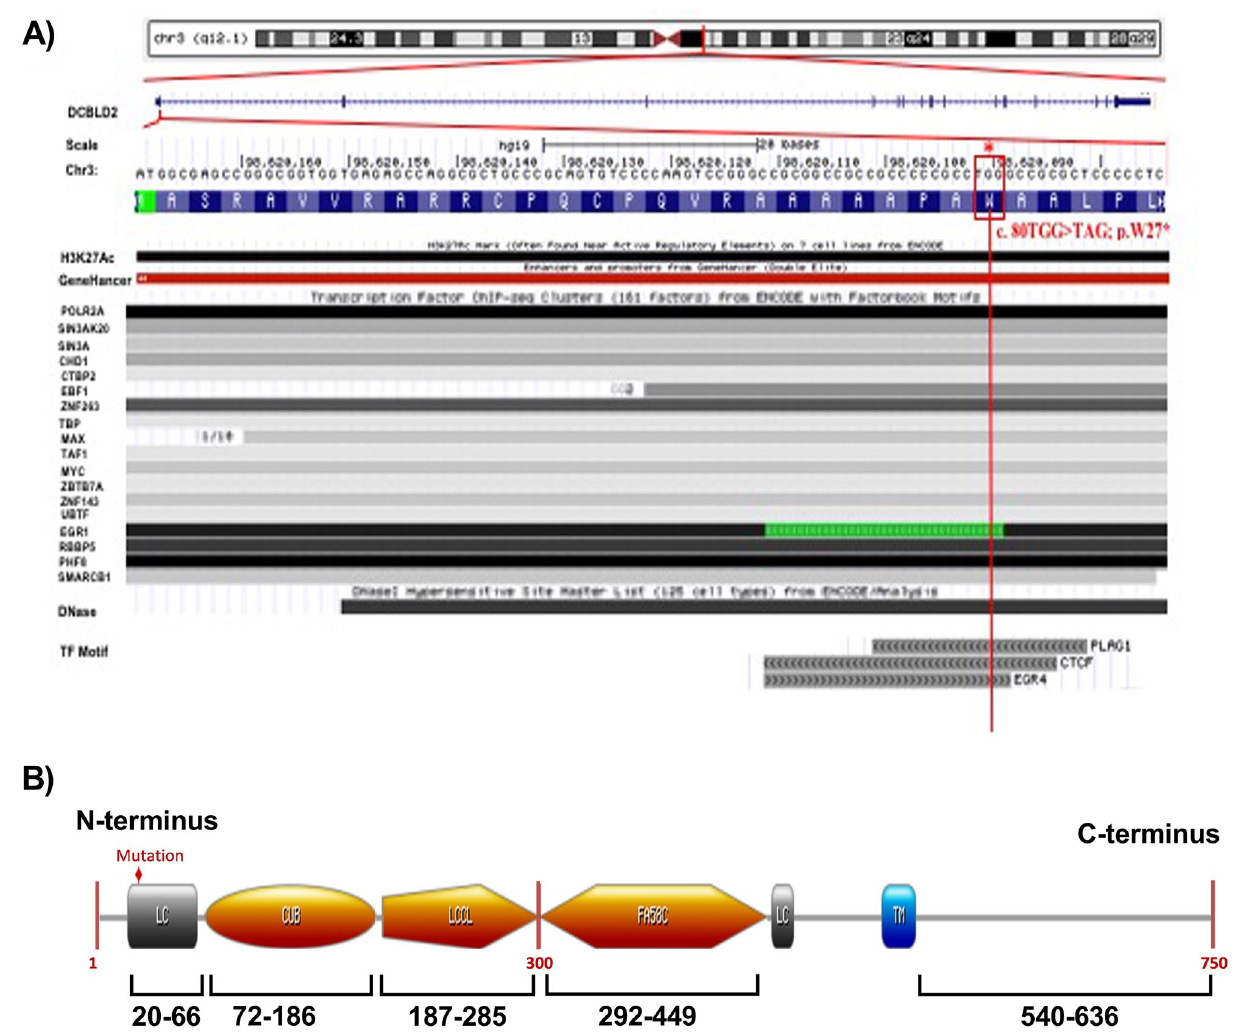
Figure 2. Schematic diagram and annotation of the identified c.80G > A, p.W27* variant in the DCBLD2 gene. ( A ) The identified nonsense variant in the DCBLD2 gene (c.80G > A; p.W27*) is located on chromosome 3 q12. The variant falls in the first exon and in some of the ENCODE functional data tracks on the hg19 in the UCSC genome browser. The variant falls in a region with strong regulatory elements including sites of DNaseI hypersensitivity, chromatin Imunoprecipitation (CHIP-seq) and predicted multiple transcription factor binding sites (TFBSs) such as PLAG1, CTCF and EGR4; the darkness of the segment is proportional to the signal strength. The arrows the strand direction. ( B ) The identified variant that creates a stop codon at amino acid 27 is located on the N-terminus of DCBLD2. The diagram was generated using prosite (https:// prosi te. expasy. org/ cgi- bin/ prosi